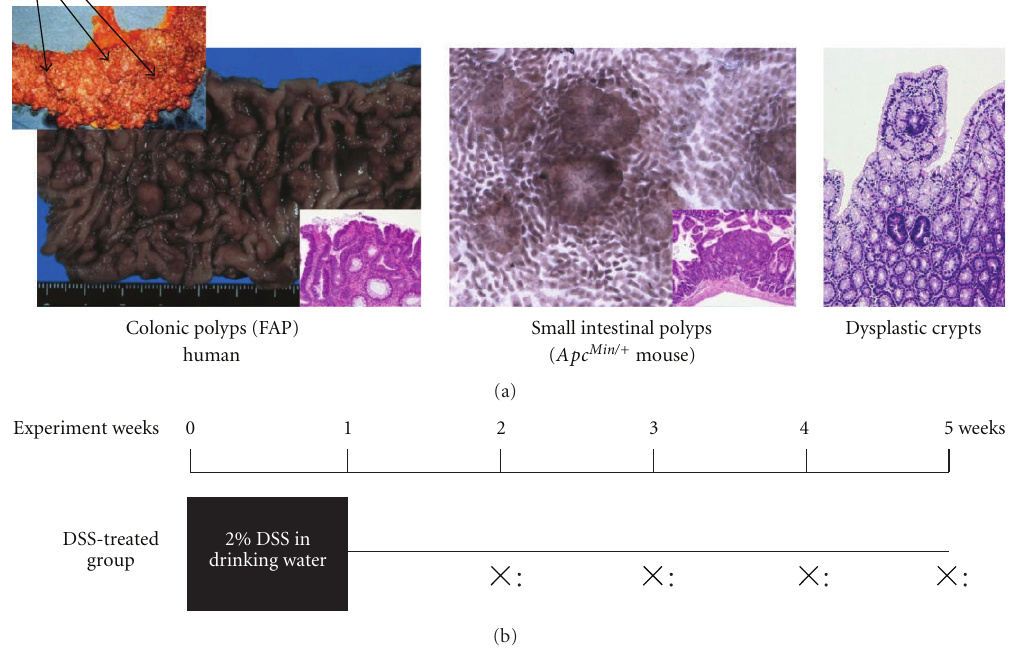
Figure 17: Colonic polyps in a familial adenomatous polyposis (FAP) patient and small intestinal polyps in an APC Min/ + mouse (a). Experimental protocol for determining whether DSS promotes the growth of colonic dysplastic crypts in APC Min/ + mice (b)